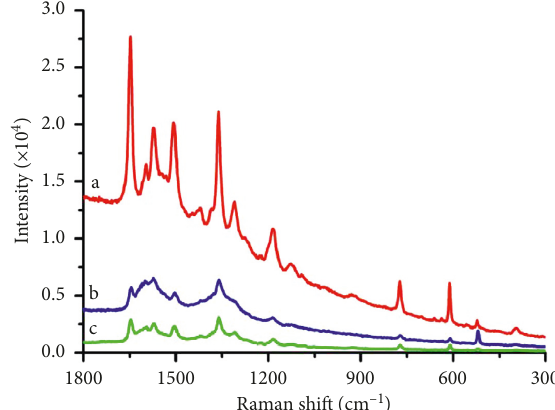
Figure 5: SERS spectra of R6G adsorbed on the surface of GO (a), rGO (10min) (b), and rGO (30min) (c),